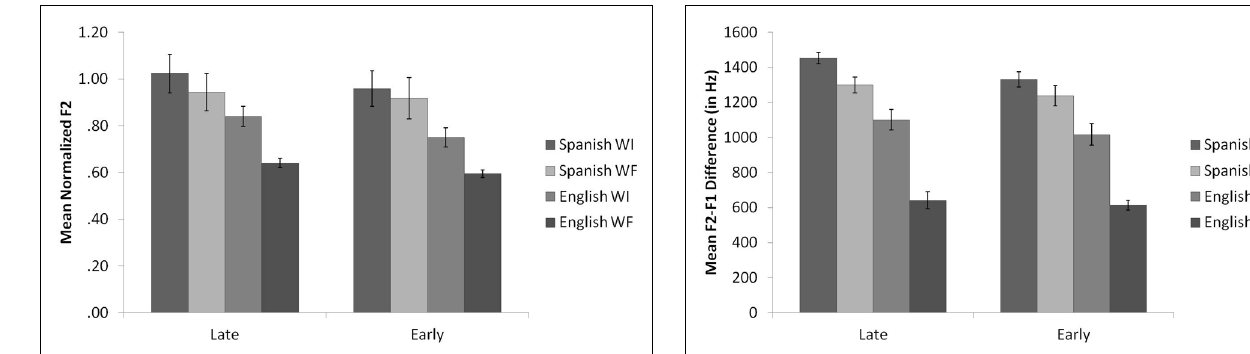
FIGURE 6 | Mean raw F2-F1 values by language and context for Late Bilinguals and Early Bilinguals. Error bars refer to standard